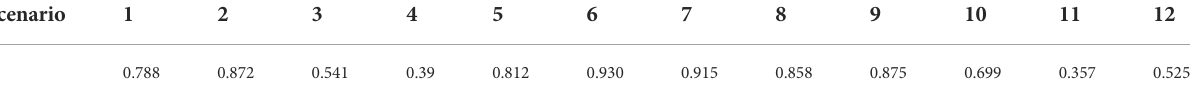
TABLE 9 Correlation degree of each cyberattack scenario to the reference scenario.